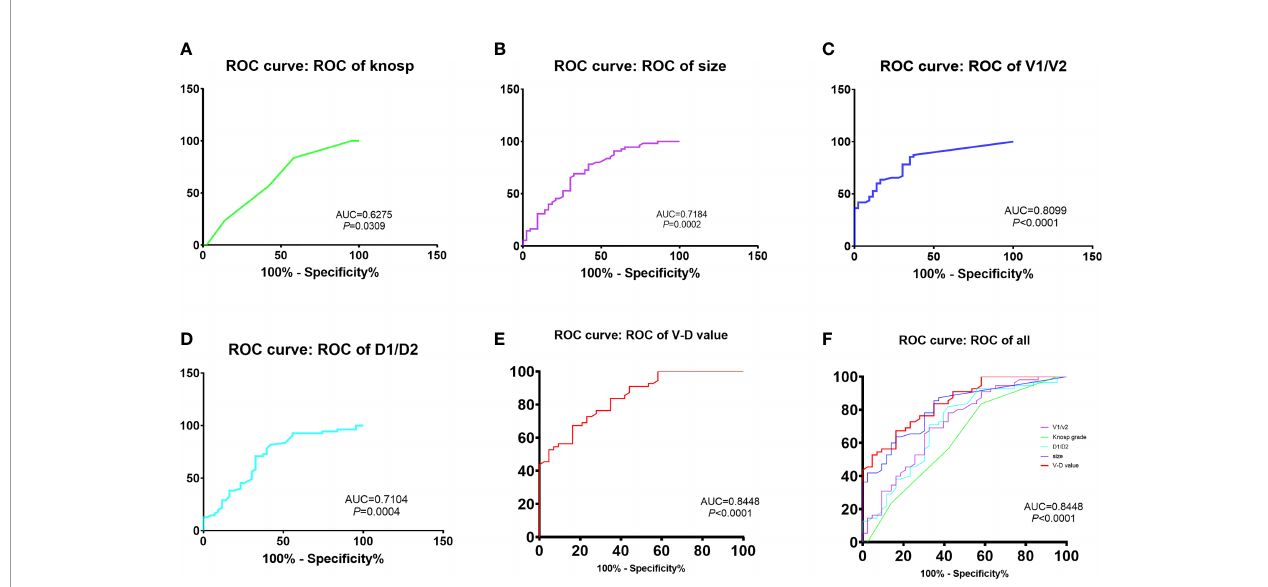
FIGURE 1 | Comparison of recurrent time divided by the cut-off value of V-D: The predictive ef fi cacy of knosp grades (A) , tumor size (B) , ratio of V1 and V2 (C) , ratio of D1 and D2 (D) and V-D value (E) . The V-D value has shown the best ef fi cacy in predicting recurrence in NFPAs (AUC = 84.48%, sensitivity = 0.837, speci fi city = 0.673,cut-off value =